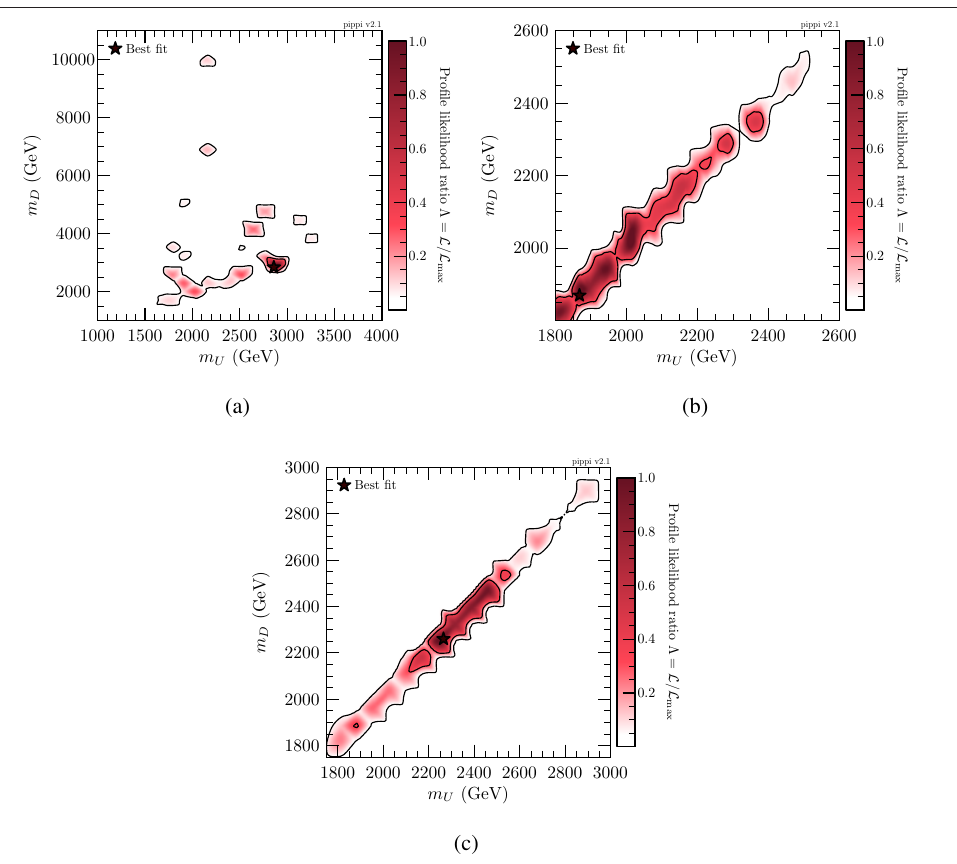
Figure 2: Profile likelihood ratios of the masses of the lightest up-type (U) and down- type (D) composite resonances in (a) the M4DCHM 5 − 5 − 5 , (b) the M4DCHM 14 − 14 − 10 , (c) the M4DCHM 14 − 1 − 10